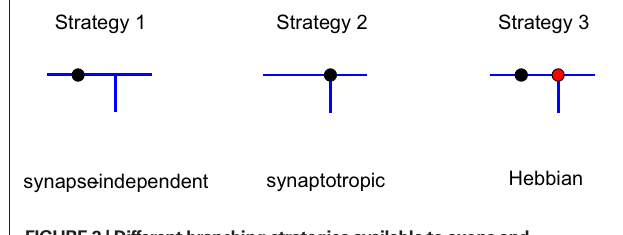
FIGURE 2 | Different branching strategies available to axons and dendrites. Strategy 1: a new branch point on the arbor (blue) can be formed anywhere, independent of the location of synapses (black circle). Strategy 2: new branch points are formed preferentially in the vicinity of existing synapses. Strategy 3: new branch points are formed preferentially in the vicinity of synapses with correlated pre- and postsynaptic activity only (red